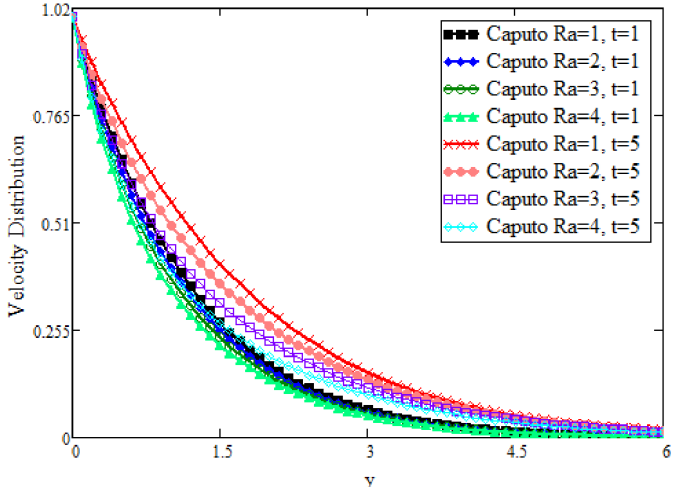
Figure 5. Comparative analysis of velocity distribution for different time